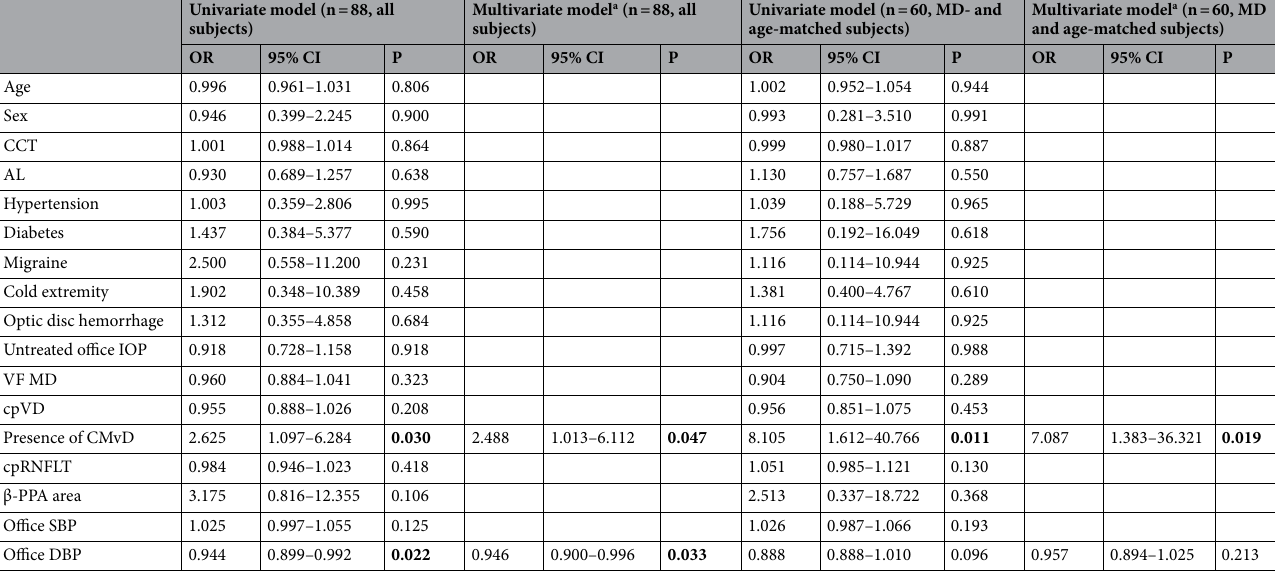
Table 6. Factors associated with extreme nighttime diastolic blood pressure dip using logistic regression analyses. MD mean deviation, OR odds ratio, CI confidence interval, CCT central corneal thickness, AL